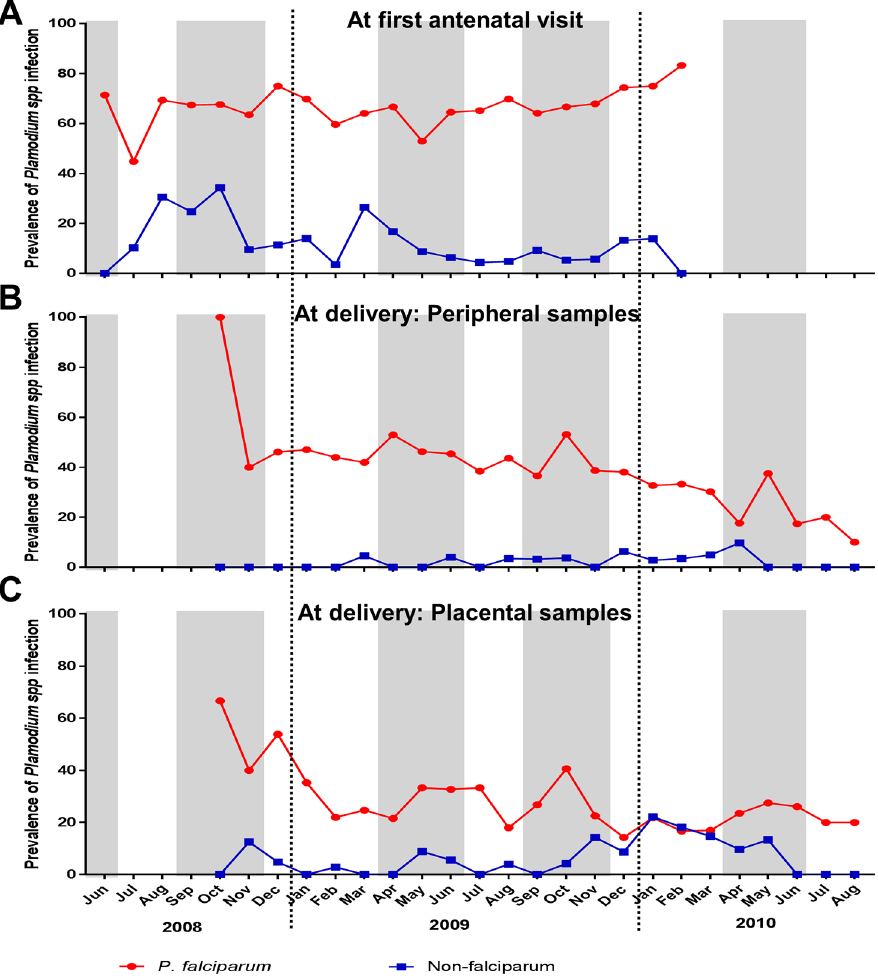
Fig 1. Monthly prevalence of P . falciparum and non- falciparum infections in Beninese pregnant women. The prevalence of P . falciparum (in red) and non- falciparum (in blue) infections detected in pregnant at the enrollment (A) and at delivery in the peripheral (B) and placental (C) blood samples are presented. Periods covered June 2008 to February 2010 corresponding to the recruitment of the pregnant women and October 2008 to August 2010 for the data collection at